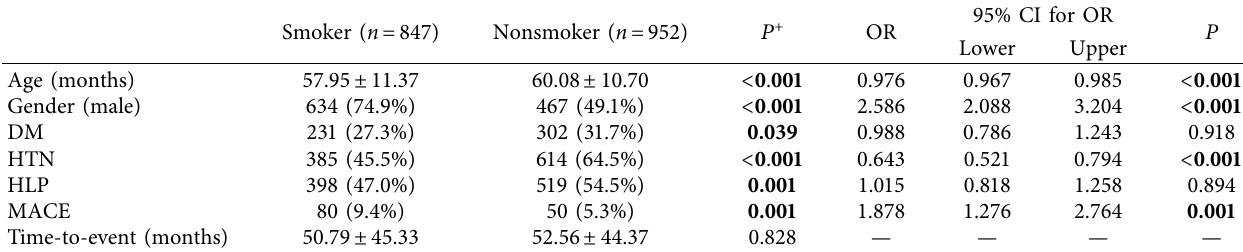
Table 1: Baseline characteristics of 1799 participants stratified by smoking status.